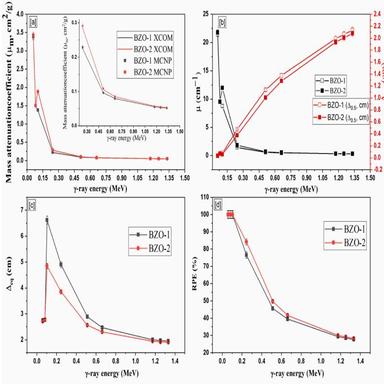
Influence of the selected γ-photon energies on (a) Mass attenuation coefficient, (b) linear and half-value thicknesses, (c) lead equivalent thickness (Δeq, cm), and (d) Radiation protection efficiency.